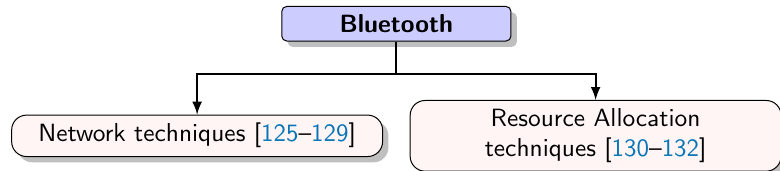
Figure 7. Energy efficiency techniques for Bluetooth